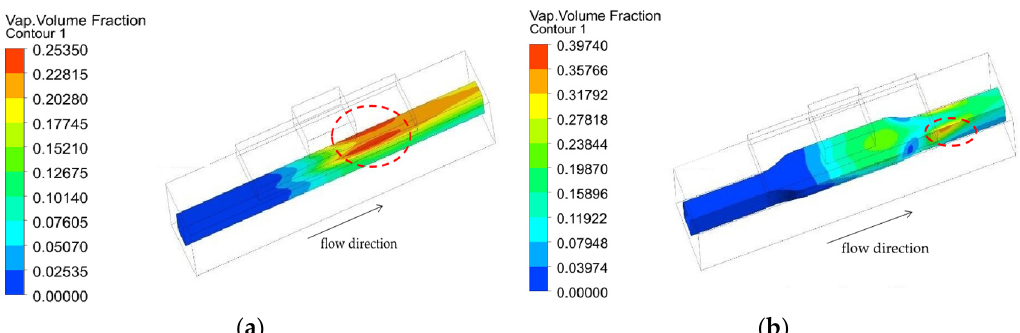
Figure 8. Vapor–phase distribution of different channel sections: ( a ) 4 mm × 3 mm; ( b ) 8 mm × 1.5 mm. The part circled by the red circle is where the maximum vapor-phase fraction occurs.